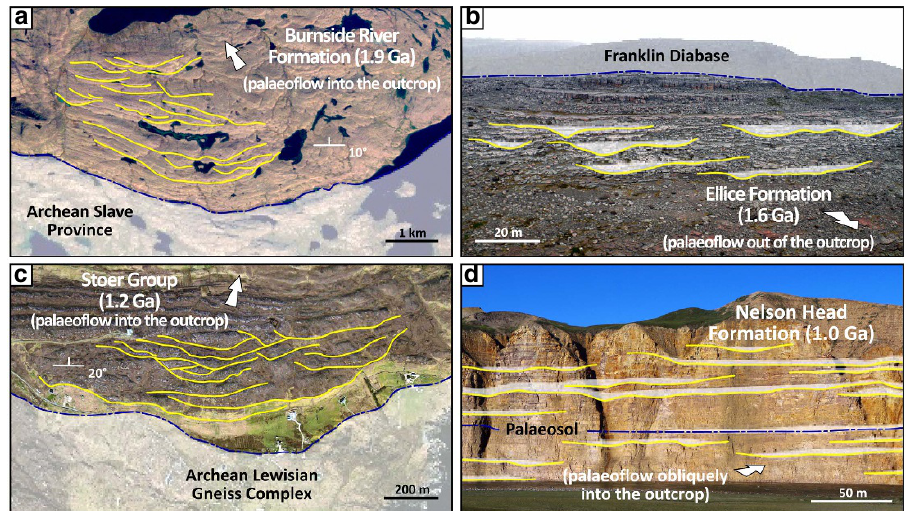
Figure 3 | Remote sensing of Proterozoic channel forms. ( a ) Satellite view of the 1.9Ga Burnside River Formation: narrow channel cluster found in proximity to basement topography. ( b ) Oblique aerial photopanel of the 1.6Ga Ellice Formation: isolated channel forms contained in amalgamated fluvial–bar complexes. ( c ) Satellite view of the 1.2Ga Stoer Group: broad channel cluster within a palaeovalley carved on basement bedrock. ( d ) Cliff exposure of the 1.0Ga Nelson Head Formation: abandoned-channel fills engulfed in amalgamated fluvial–bar complexes. Basal channel surfaces reported with yellow lines.